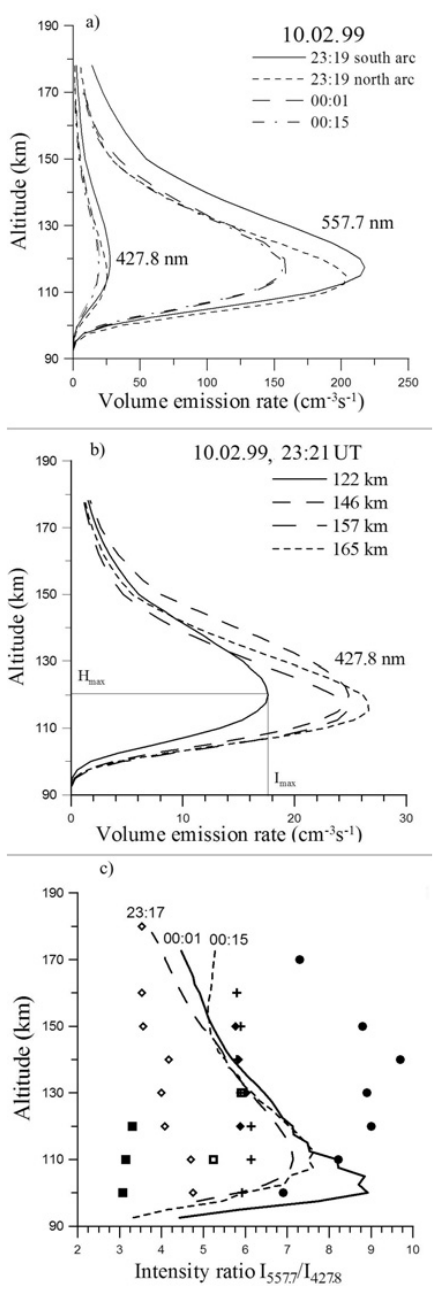
Fig. 5. (a) , (b) : Volume emission rates of 427.8 and 557.7nm ob- tained during various observational conditions; (c) : Intensity ratio I 557 . 7 / I 427 . 8 . Lines mark the results, obtained trom tomographic reconstructions, crosses mark the results by Feldman (1978), solid rhomb – Vallance Jones (1979), open rhomb – Sharp et al. (1979), circle – Deans et al. (1978), solid square – McDade et al. (1985), open square – Stelle et al.